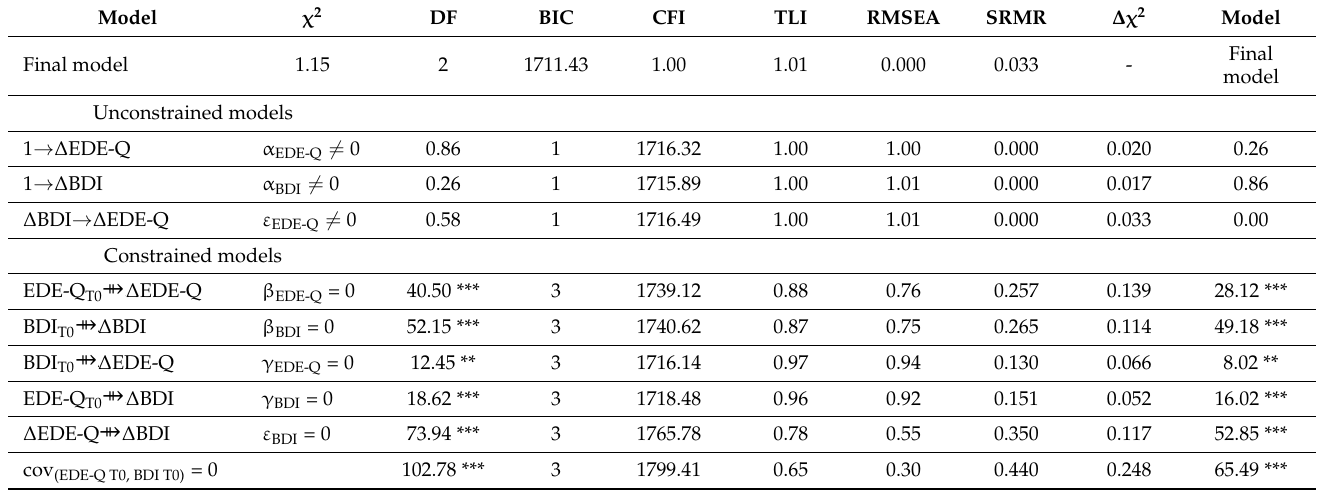
Table 2. Results of nested model comparisons. The final model (reported in the first row) was used as a comparator for all analyses. For every nested model, the variation with respect to the final model is described in the first column. For every model, common goodness-of-fit measures are reported.